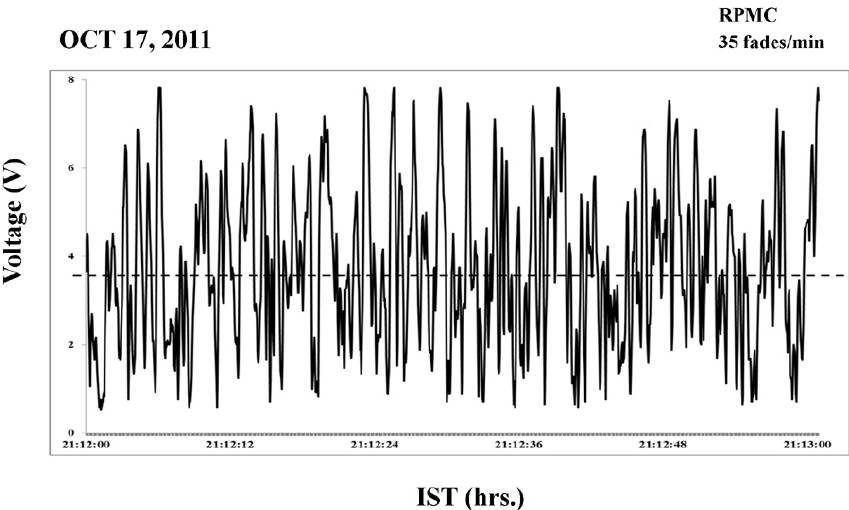
Fig. 2. Sample VHF (250MHz) amplitude scintillation (voltage) record of 1-min duration observed at RPMC in the post-sunset period of 17 October 2011. The plot exemplifies the fade rate calculation. The dotted horizontal line indicates the mean signal level. Estimated fade rate (calculated following mean level crossing technique) is also